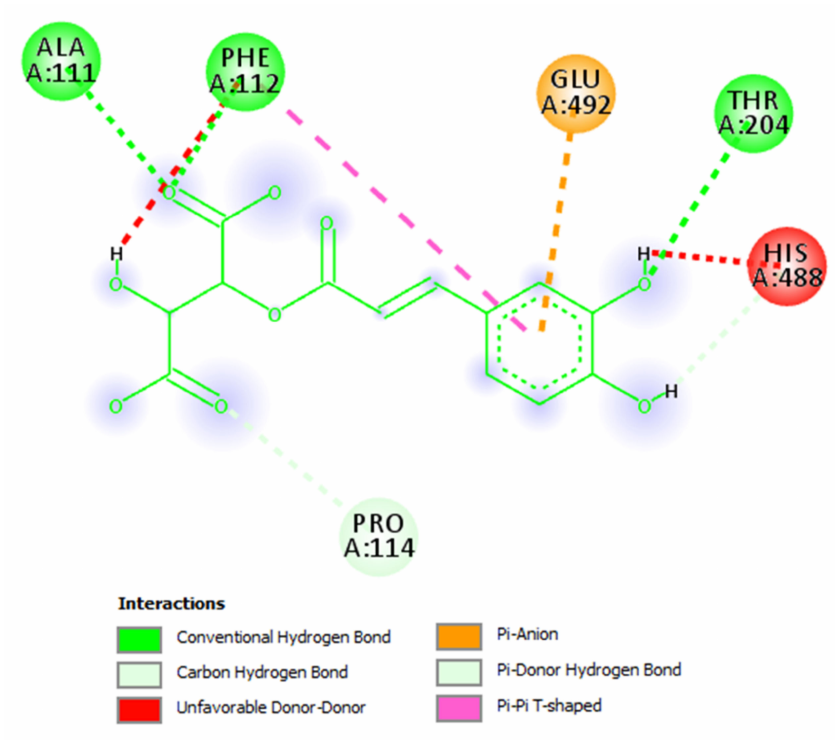
Figure 10. Putative interactions between caftaric acid and monoamine oxydase-A (MAO-A; PDB: 2ZX5). Free energy of binding ( ∆ G) and affinity (Ki) are − 7.5 kcal/mol and 3.2 µ M,